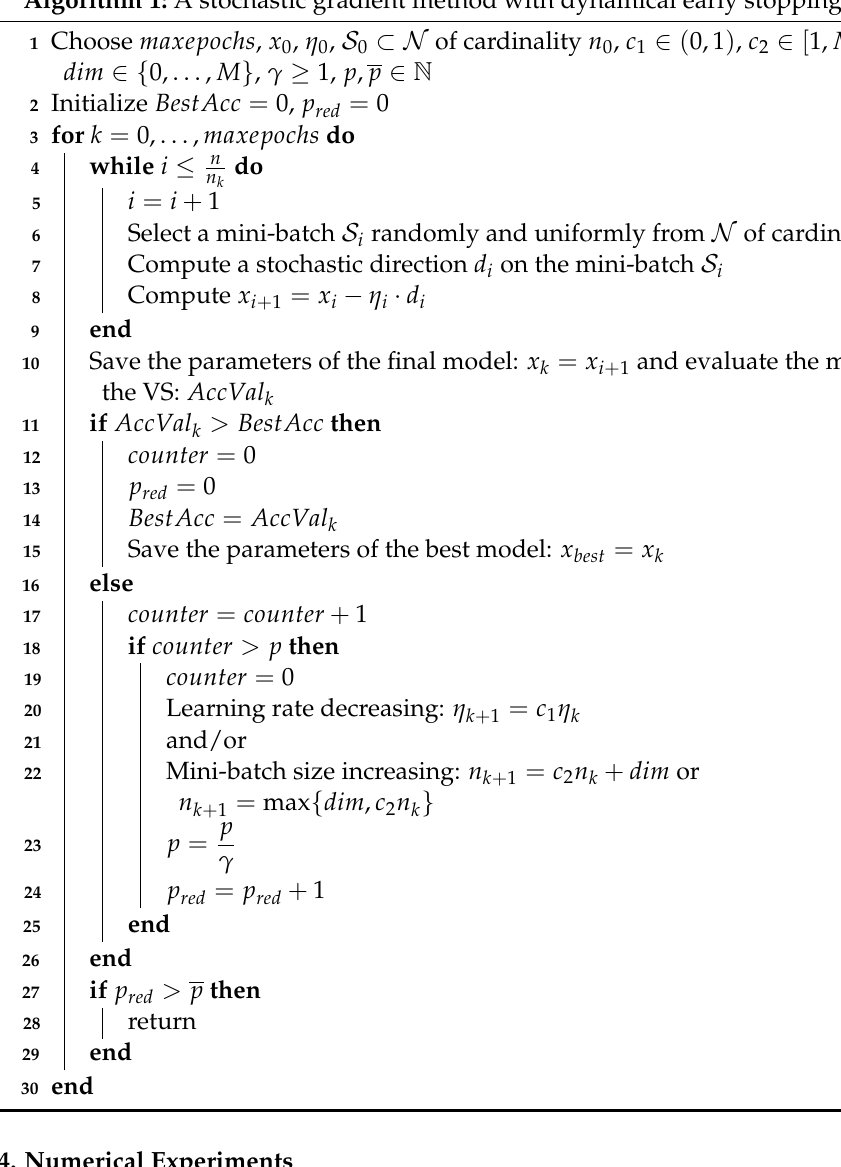
Algorithm 1: A stochastic gradient method with dynamical early